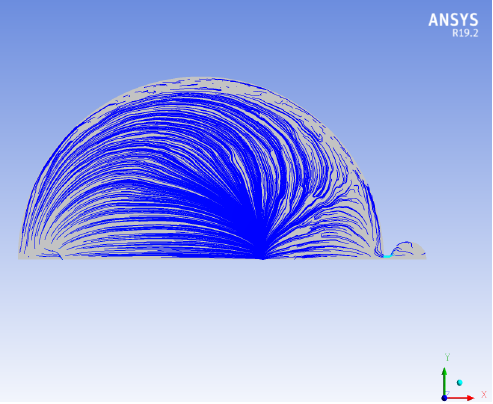
Figure 17. Computed streamlines for the micropump [22] during the pushing phase.